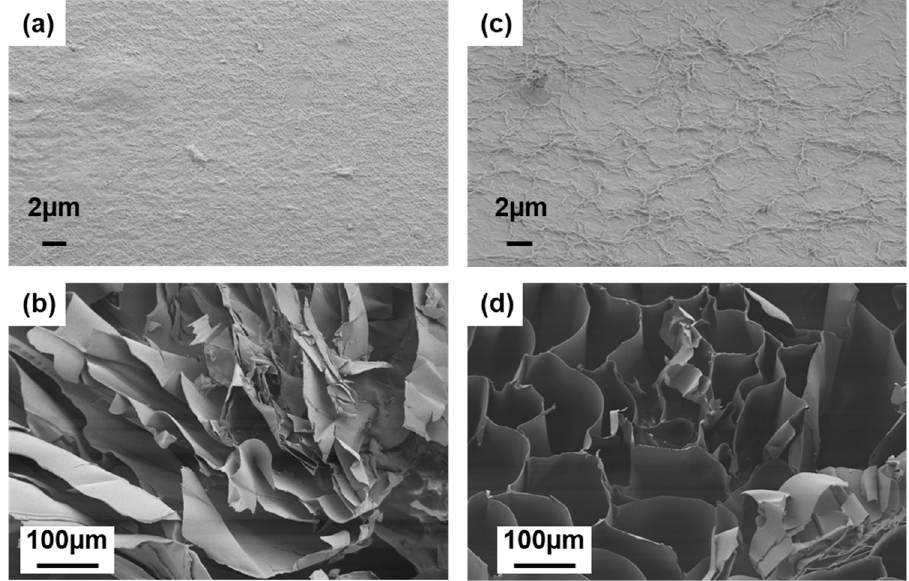
Figure 5. The surface and cross-sectional SEM images of ( a , b ) SA and ( c , d ) SA–DCNC-40 hydrogel bead at different magnifications.